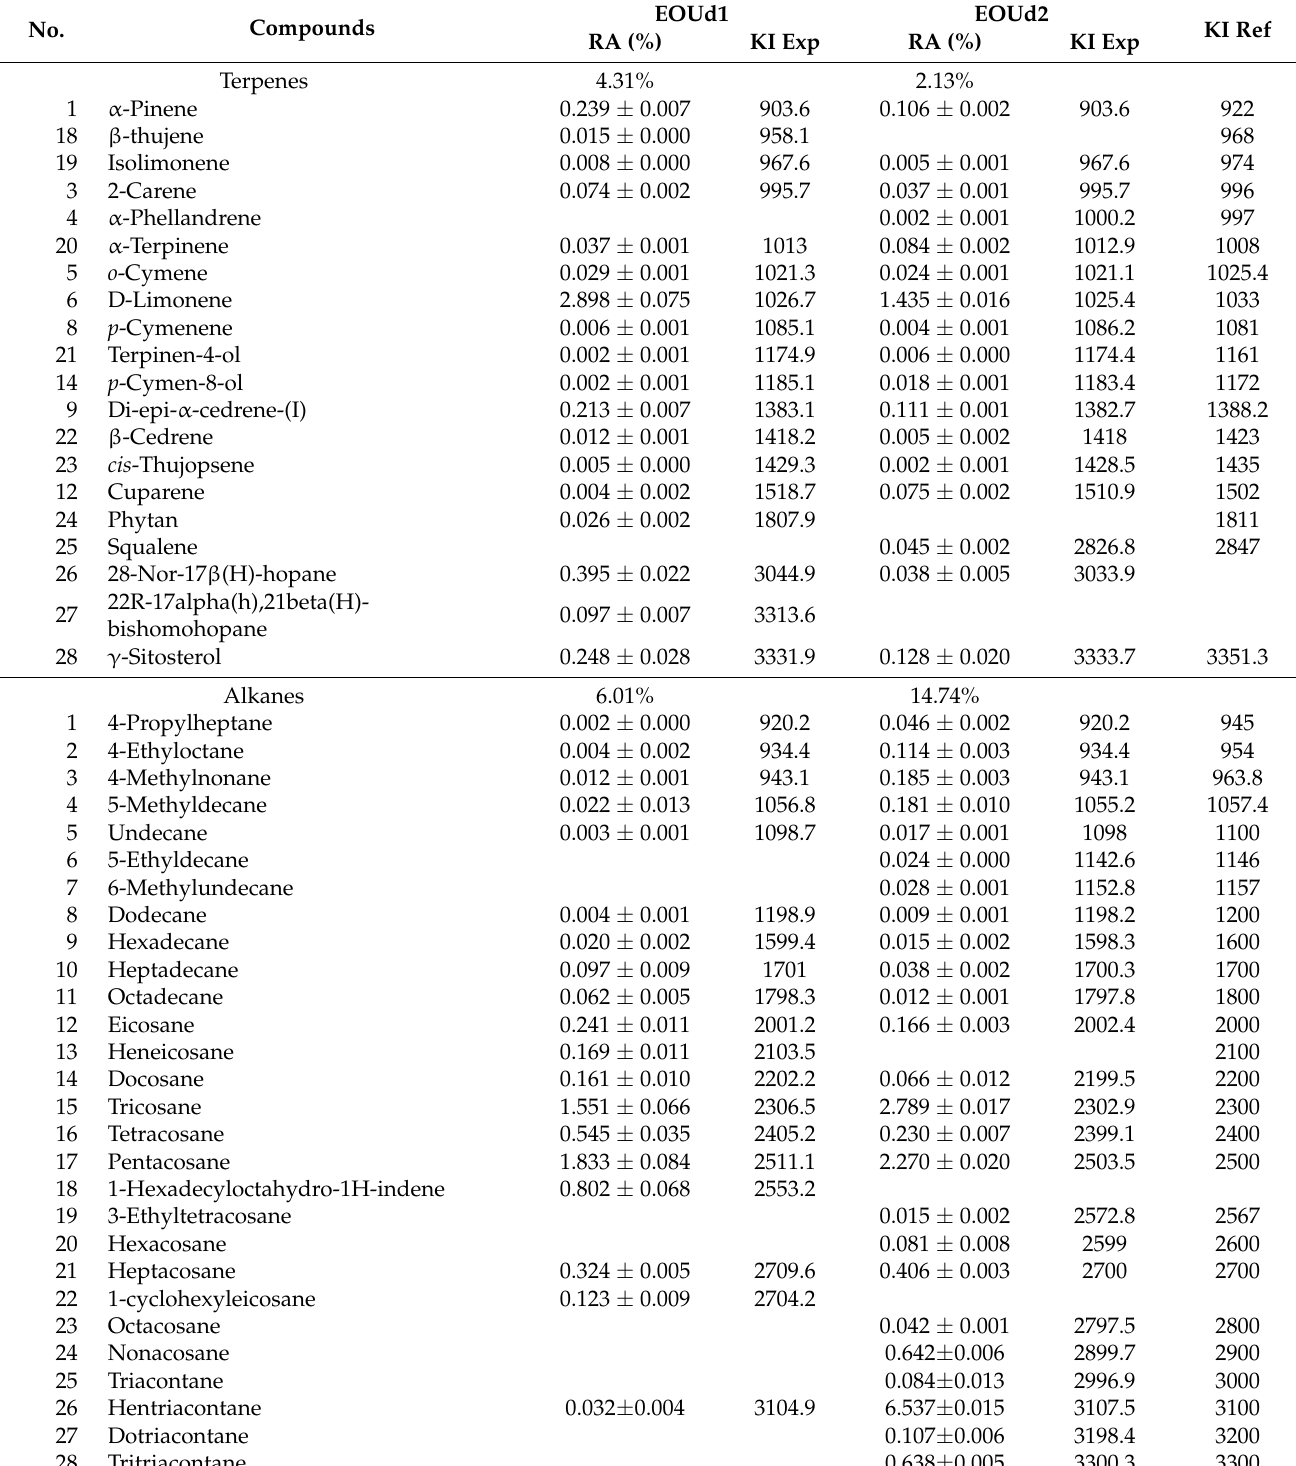
Table 3. Identified compounds of U. dermestoides essential